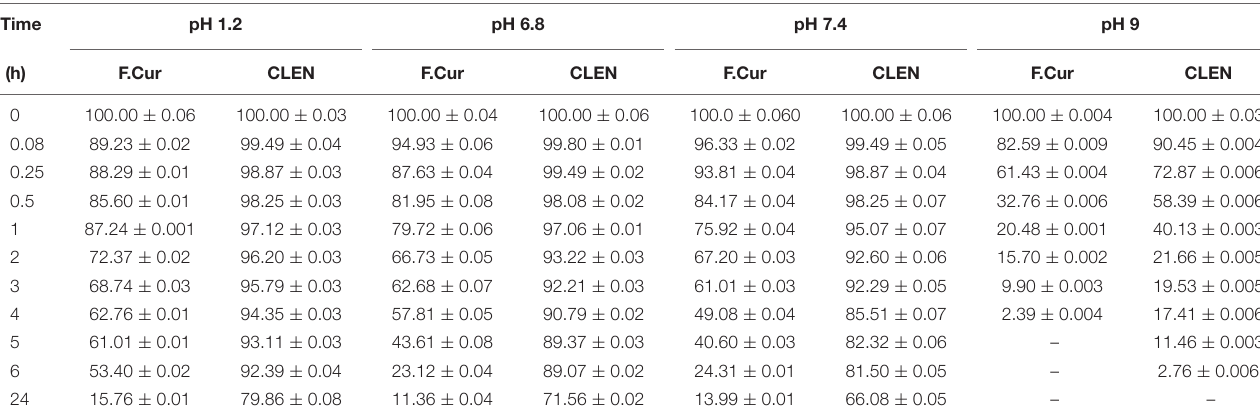
FIGURE 4 | Stability studies of CLEN ( n = 3). There was no significant change ( p ≤ 0.05) in the values of various parameters upon storage. (A) TDC and Entrapment, (B) Particle Size, (C) , Zeta Potential, and (D) PDI. TABLE 2 | Percentage remaining of free curcumin (F.Cur) and CLEN with time at various pH ( n = 3). Time pH